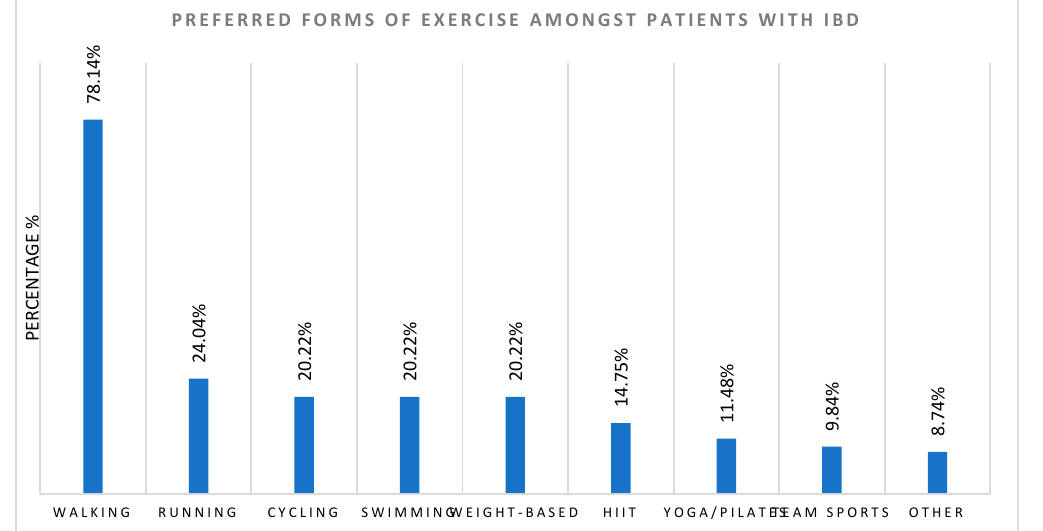
Figure 3. Preferred forms of exercise, total responses n = 183. Multiple options allowed per patient.